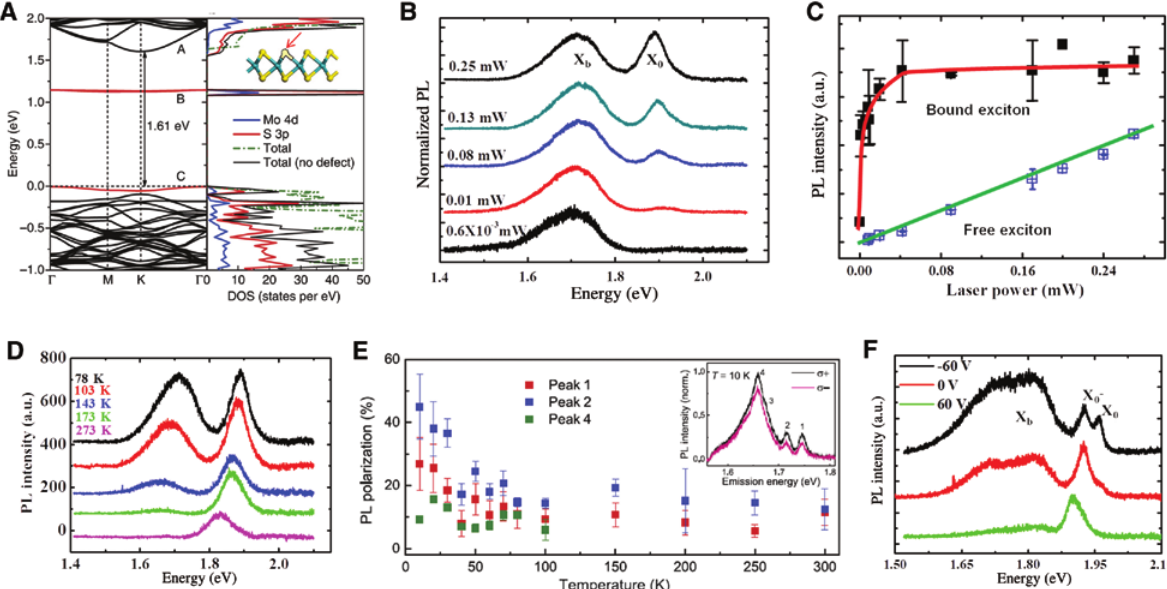
5 × 5 supercell with an SV. Reprinted with permis- Figure 8: (A) Band structure (left) and partial density of states (right) of a monolayer MoS 2 sion from [21]. Copyright 2013 Nature Publishing Group. The localized states are highlighted by red lines. Green dashed line corresponds to the case without SV. (B) Laser power dependence of PL spectra of MoS , normalized by the intensity of X . (C) PL intensity of bound exciton 2 b and free exciton of MoS with increasing laser power. (D) Temperature dependence of PL spectra for MoS . (E) Temperature dependence of 2 2 the PL circular polarization of monolayer WSe . Inset: Polarization-resolved PL spectra for σ + and σ − detections. Reprintedwith permission 2 from [110]. Copyright 2016 Nature Publishing Group. (F) Gate dependence of PL spectra for MoS measured at 83 2